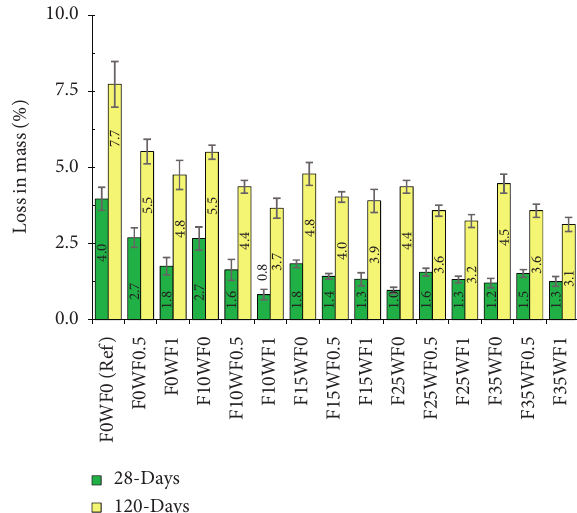
Figure 25: Loss in mass of each HSC mix with different incorporation levels of FA and WSF as a result of acid